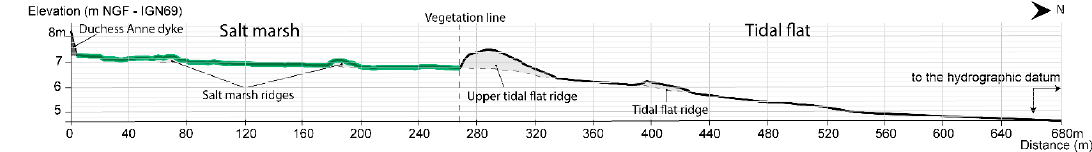
Figure 2. Schematic topographic profile, Western part of the Bay of Mont-Saint-Michel.